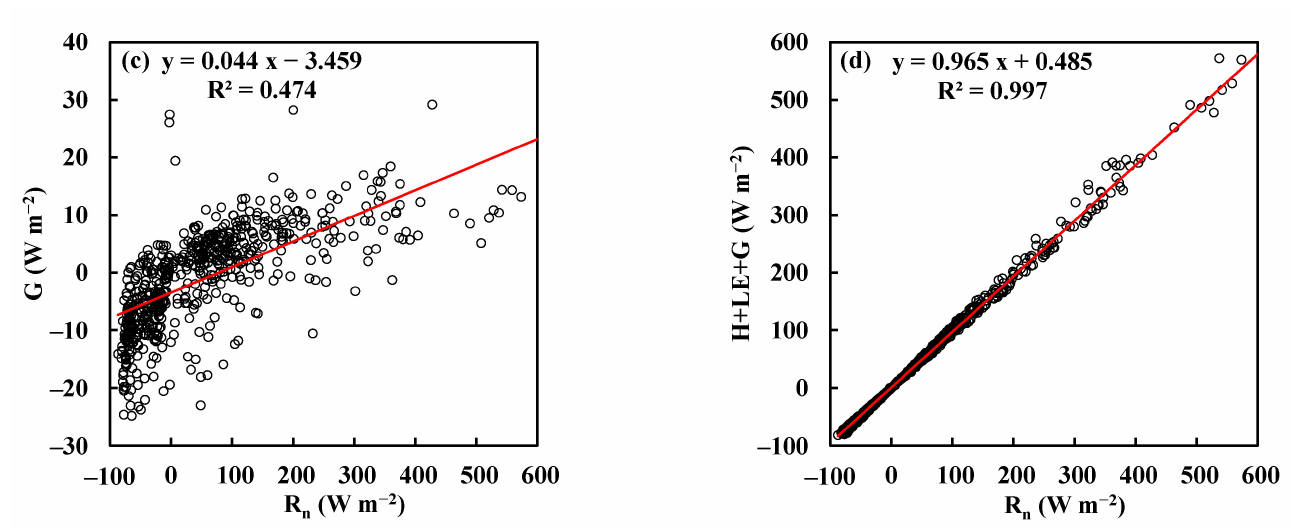
Figure 3. Scatter plots between R n and H ( a ), LE ( b ), G ( c ), and H+LE+G ( d ) above the